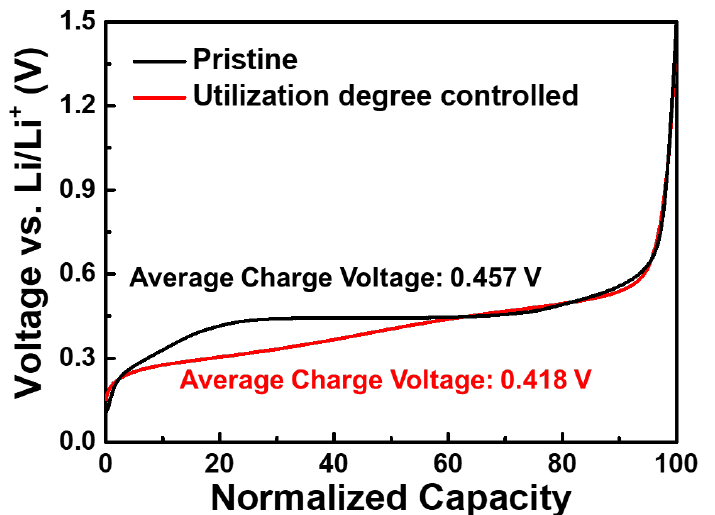
Figure 5. Normalized charge voltage profiles of a pristine NSD electrode and a controlled NSD electrode with different utilization degrees (NSD-SOC50).